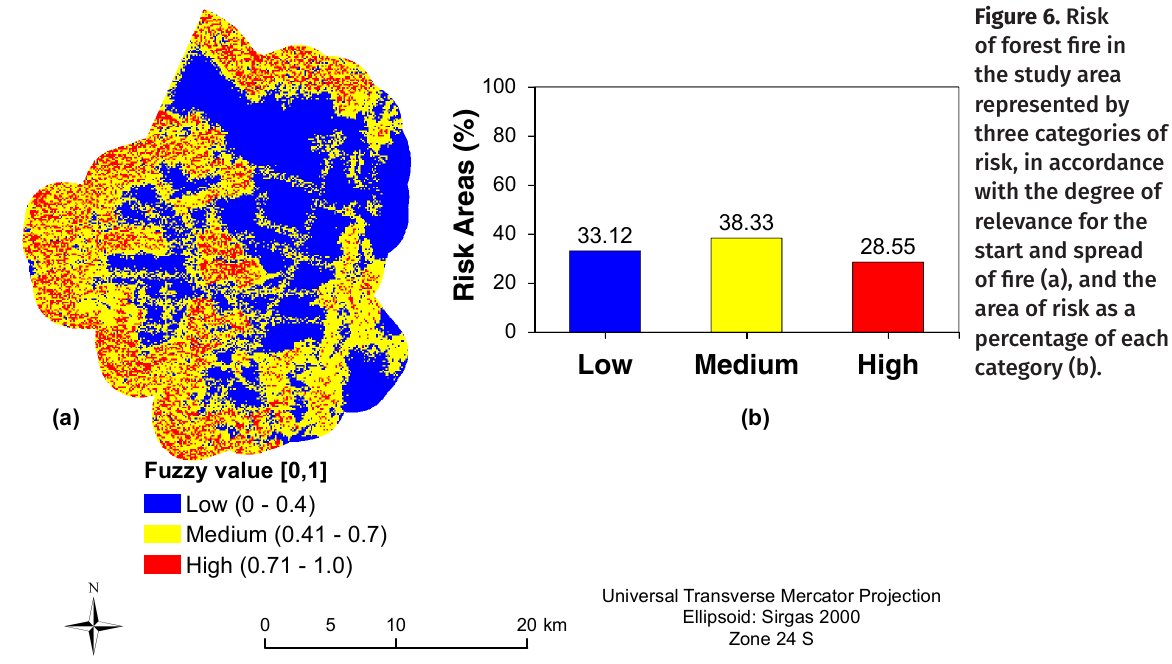
Figure 6. Risk of forest fire in the study area represented by three categories of risk, in accordance with the degree of relevance for the start and spread of fire (a), and the area of risk as a percentage of each category